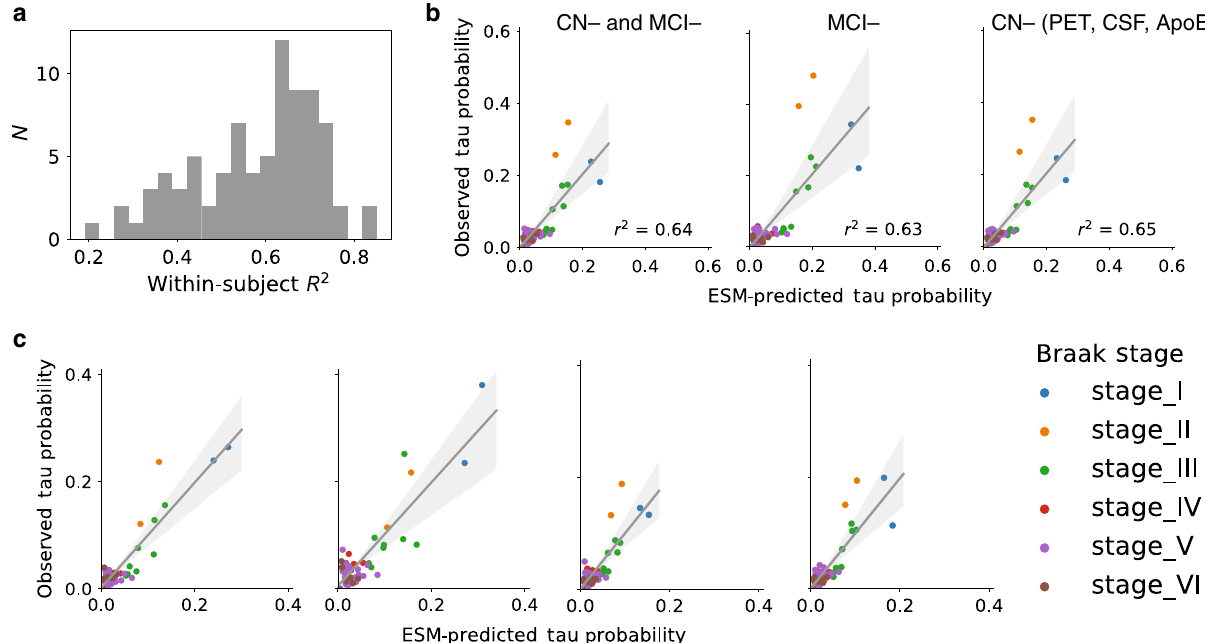
Fig. 5 Model performance in CN − individuals. All plots are based on the best- fi tting ESM model described in the text. a The distribution of r 2 values representing the range in individual-level model fi t across all CN − subjects. b For each plot, each dot represents a region. The x -axis represents the mean simulated tau-positive probabilities across the population, while the y -axis represents the mean observed tau-positive probability. Predicted and observed patterns are plotted for (left) all A β − individuals ( n = 104), (middle) only A β − MCI subjects ( n = 22), and (right) individuals without elevated A β − PET or A β − CSF, and who carry no APOE 4 alleles ( n = 62). c Four exemplary subjects spanning both cohorts are plotted. All four subjects are cognitively normal with MMSE 29 – 30 and do not carry an APOE 4 allele. Their respective ages are 73, 63, 71 and 78. Even at very low (subthreshold) levels, the distribution of tau follows a pattern similar to Braak staging, and which is predicted by anatomical connectivity